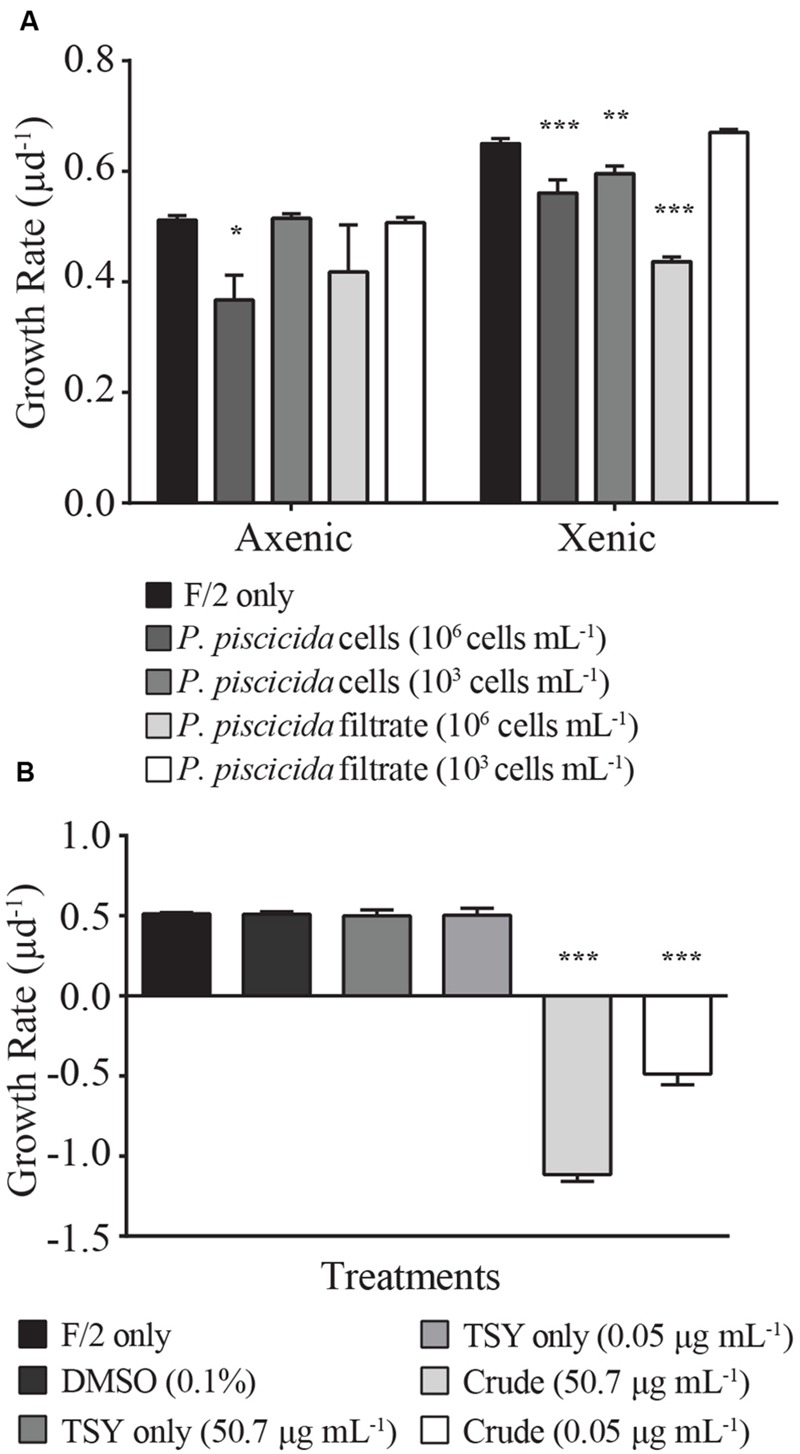
Growth rates (μ d-1) of Emiliania huxleyi (strain 624, either xenic or axenic) were measured in response to (A) live Pseudoalteromonas piscicida cells and filtrate. Growth rates (μ d-1) of axenic E. huxleyi (strain 624) were measured in response to (B) crude extracts of P. piscicida secreted metabolites and appropriate media (F/2 and TSY) and solvent (DMSO) controls. Compared to the control, the growth rate of E. huxleyi significantly decreased in response to high concentrations (106 cells mL-1) of P. piscicida and the crude extracts. Additionally, high concentrations of culture filtrate and low concentrations (103 cells mL-1) of P. piscicida resulted in a significant decrease in E. huxleyi growth but only in the xenic subculture. Significance is denoted as being less than 0.05 (∗), less than 0.01 (∗∗), or less than 0.001 (∗∗∗). For all treatments, n = 3. All error bars are one standard deviation of the mean.